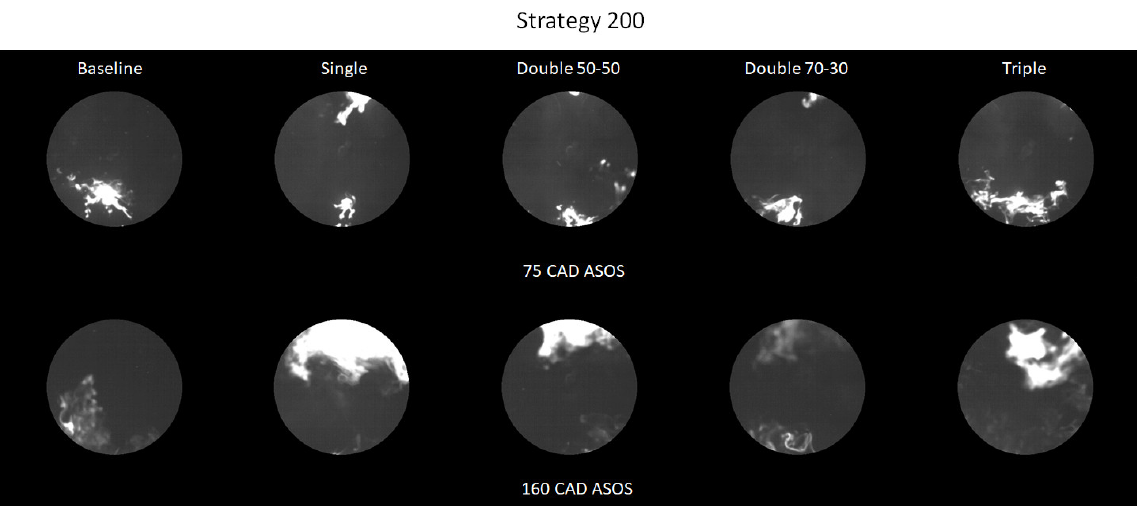
Figure 16 . Image sequence of late combustion stages at 75 and 160 CAD ASOS, for the 200-injection